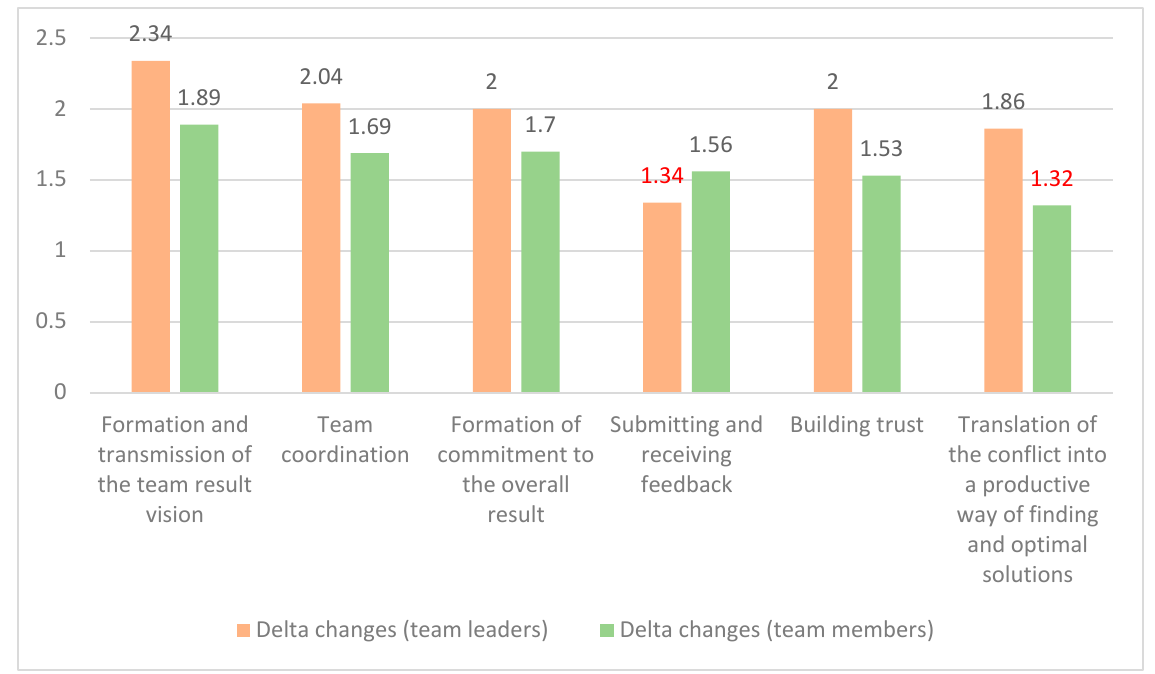
Figure 8. Average values of skill gains in the Leaders Team program.